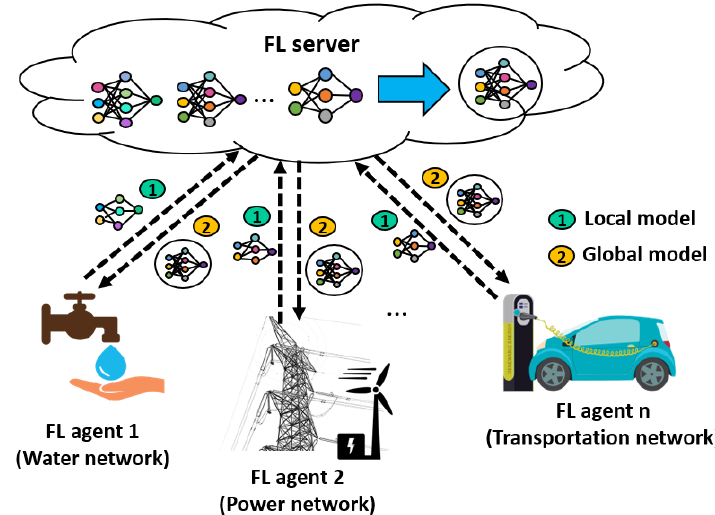
Figure 1. FL process considering critical infrastructure agents